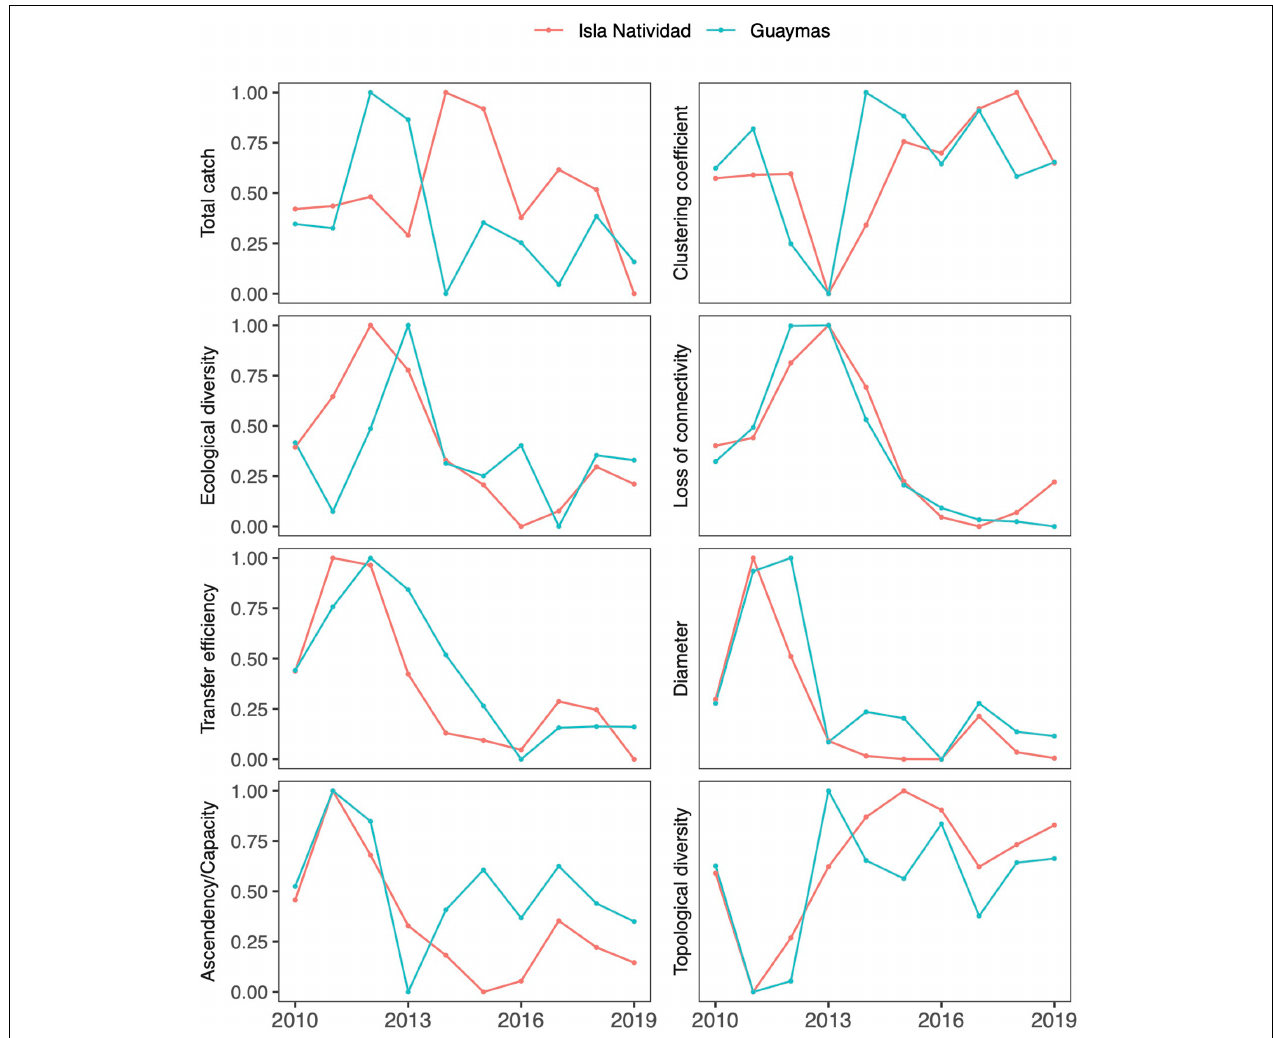
FIGURE 5 | Estimated trends in ecological (left panels) and topological (right panels) indicators resulting after calibrating the Isla Natividad and Guaymas models. All indices were scaled from 0 to 1 for comparison